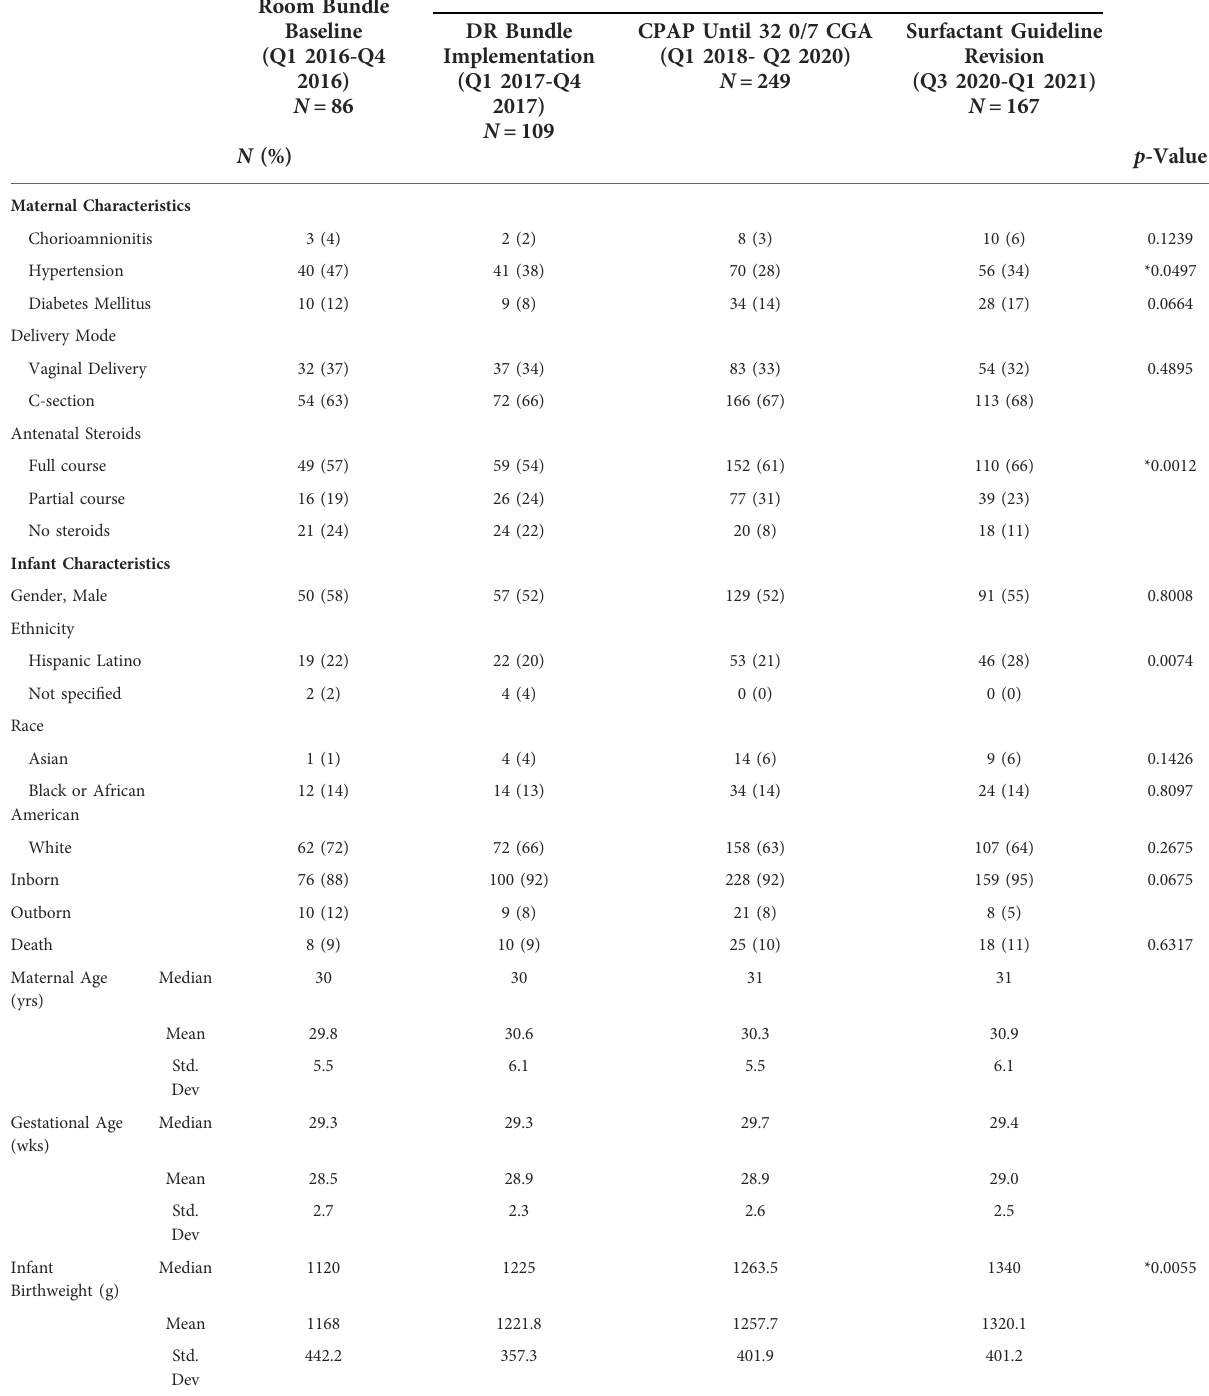
TABLE 1 Cohort demographics Pre- and post-quality improvement initiative